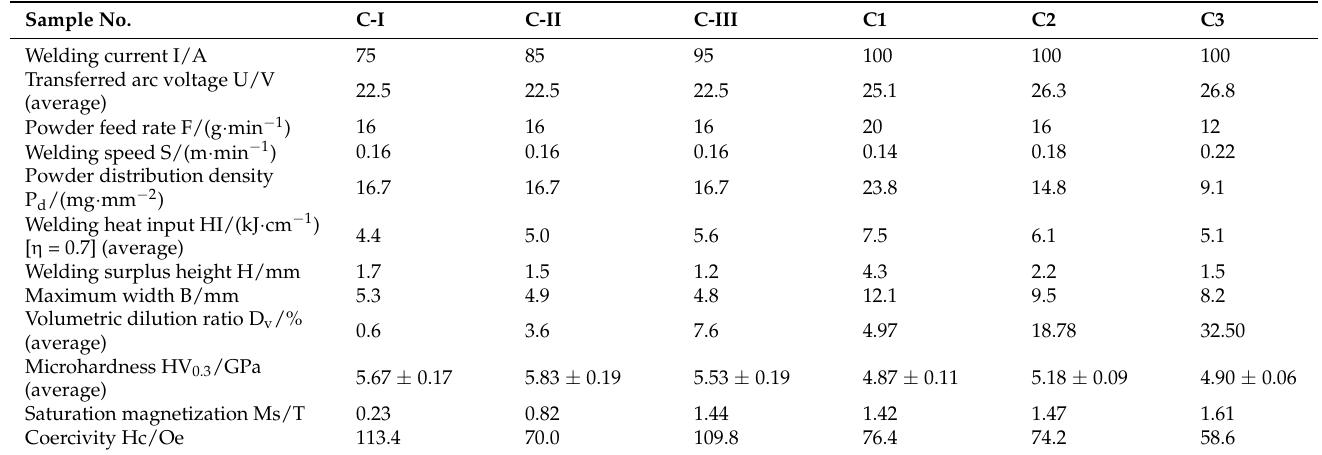
Table 3. Varying parameters during PTA welding, welding surplus height H, coating maximum width B, volumetric dilution ratio from substrate Dv, cross-sectional hardness HV 0.3 and magnetic properties of the as-welded